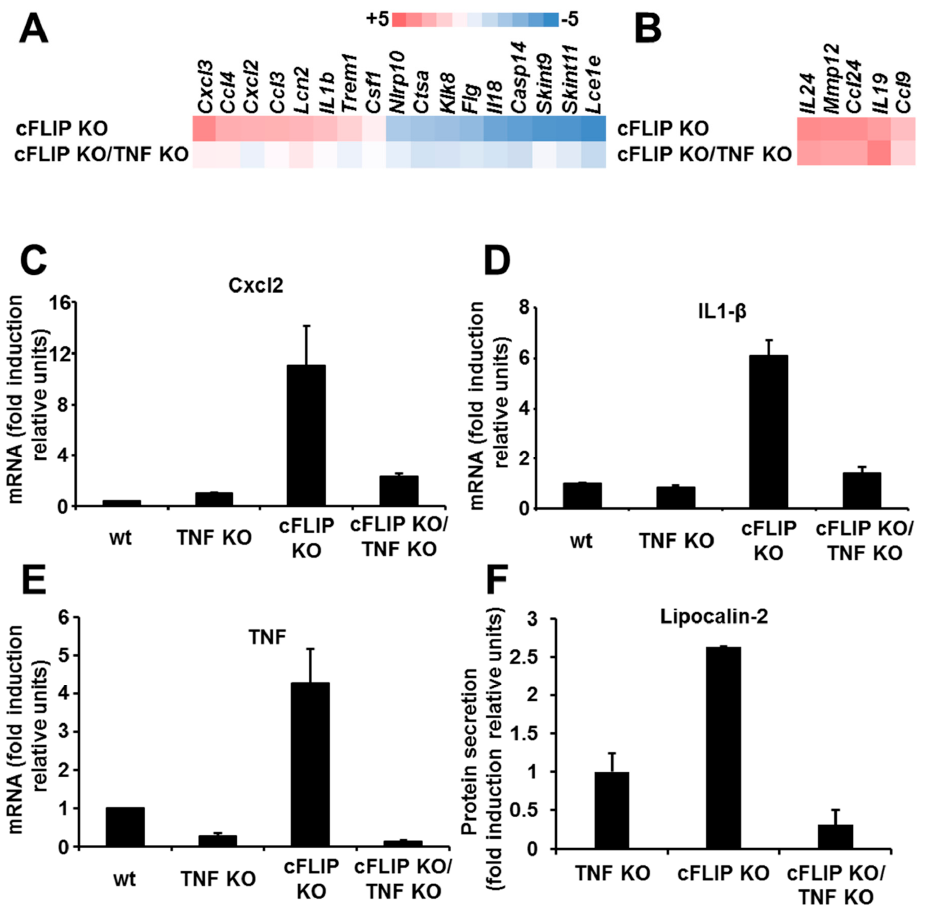
Figure 4. TNF-dependent modulation of gene expression in cFLIP-deficient epidermis. ( A , B ) Heat maps of inflammatory genes related to ( A ) TNF-dependent and ( B ) TNF-independent genes in epidermis isolated from cFLIP KO and cFLIP KO / TNF KO mice compared to TNF KO mice. The array experiment was performed with messenger RNAs (mRNAs) pooled from 3–6 animals per genotype. ( C – E ) mRNA expression of (C) Cxcl2, (D) Il-1 β , and ( E ) TNF in epidermis isolated from control, TNF KO, cFLIP KO, and cFLIP KO / TNF KO mice. Error bars represent the standard error of the mean (SEM) of two independent experiments. ( F ). Lipocalin-2 secretion from immortalized keratinocytes isolated from TNF KO, cFLIP KO, and cFLIP KO / TNF KO mice. Immortalized keratinocytes were pooled from three independent